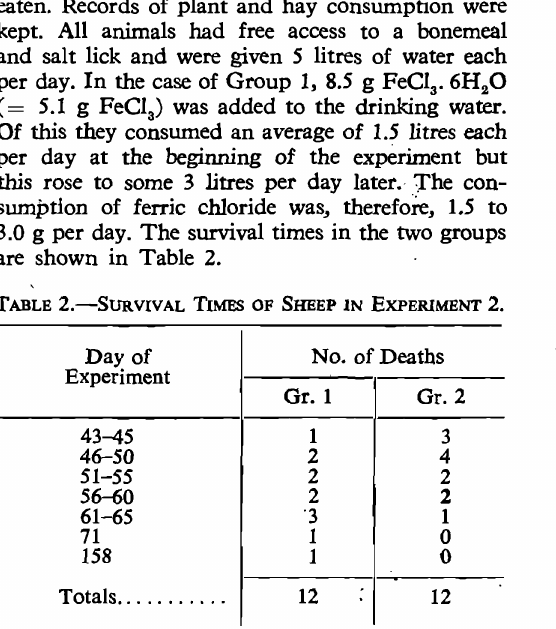
TABLE 2.-SURVIVAL TIMES OF SHEEP IN EXPERIMENT 2.